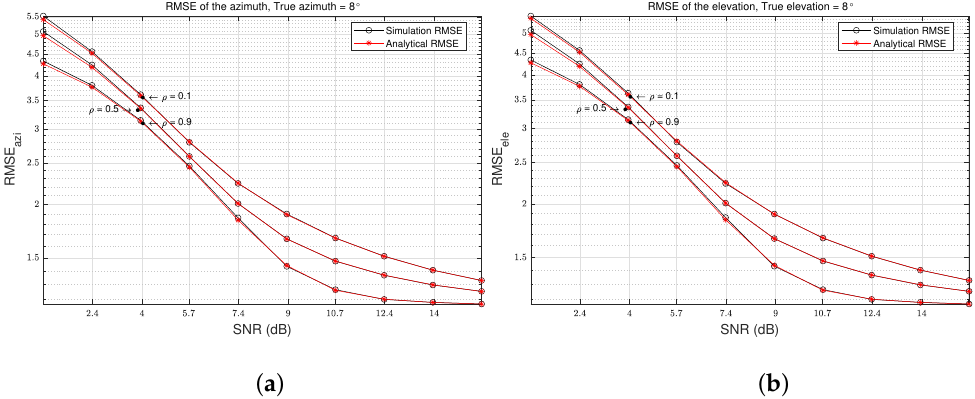
Figure 7. RMSE when the target’s azimuth and elevation are 8 ◦ . ( a ) RMSE of ˆ θ azi . ( b ) RMSE of ˆ θ ele